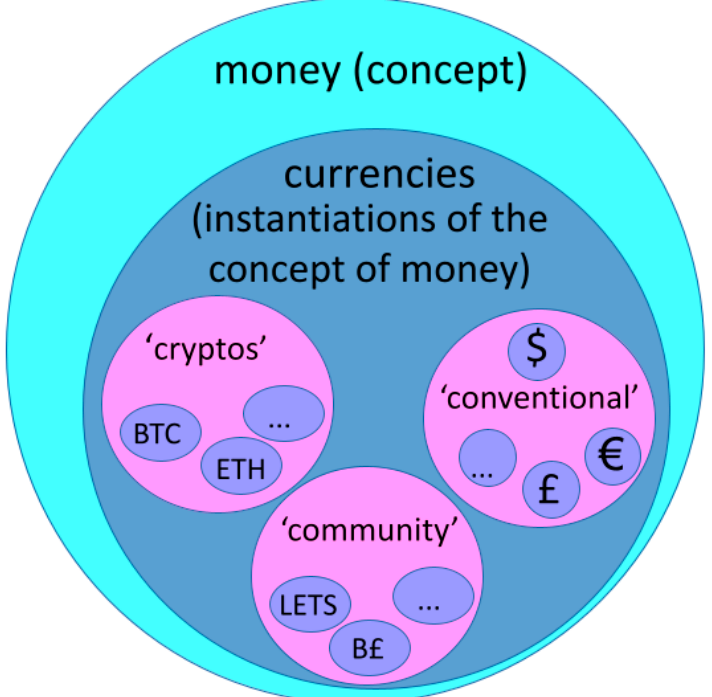
Figure 1. Proposed definitions of “money” and “currencies” as a set diagram.